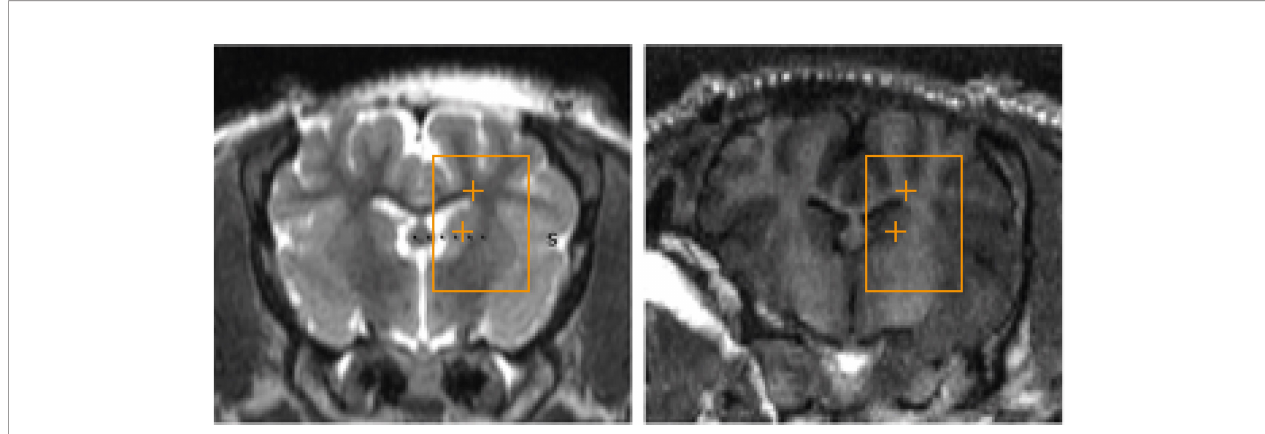
FIGURE 4 | Three-axial representation of the treatment-planning phase prior to insonation. Insonation targets are represented by orange cross signs within Basal Ganglia and Periventricular White Matter. Each location was composed of 10 sub-sonication spots that were alternately targeted by the tracking system to exploit the “ off-duty ” time of each single